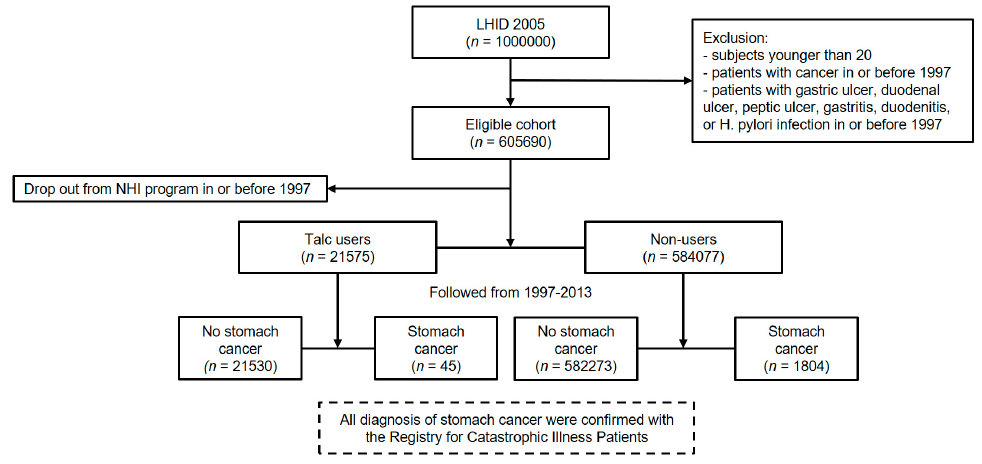
Figure 1. Data collection